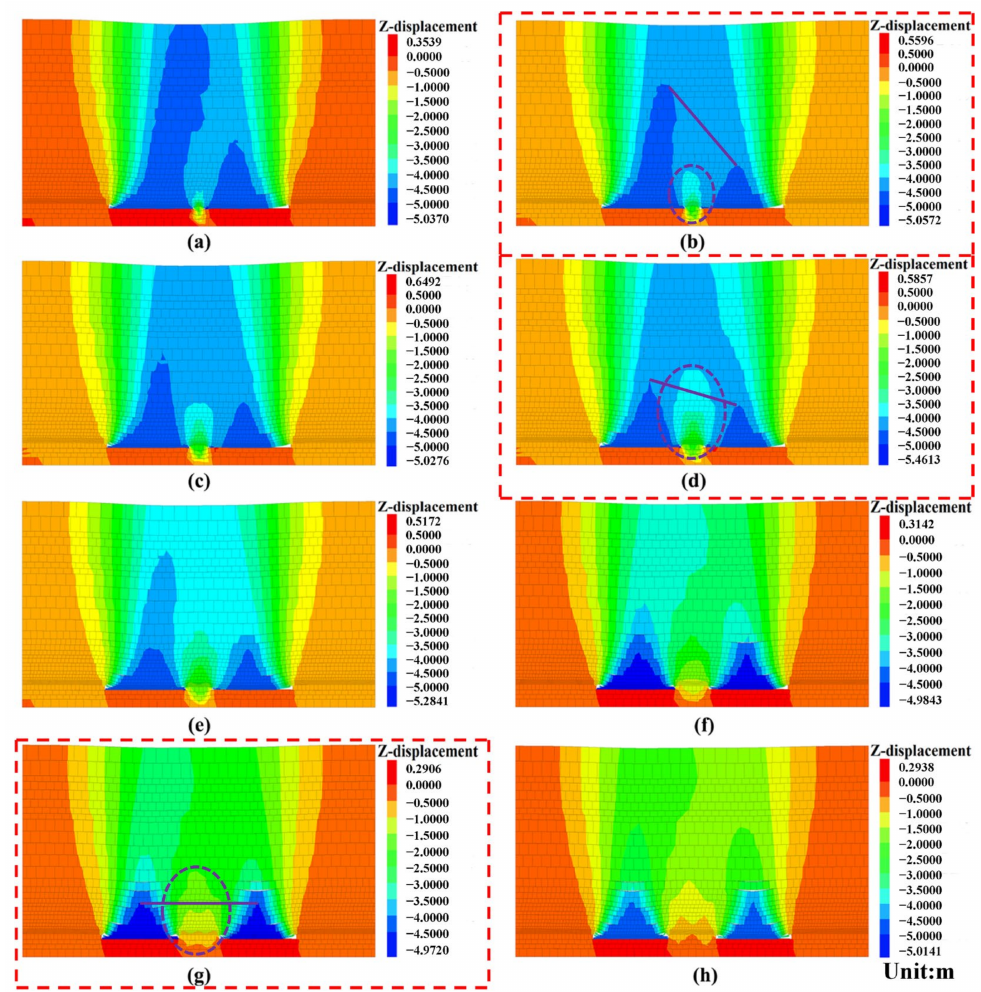
Figure 7. Subsidence conditions of overlying strata in the GAWF for different section coal pillar widths. ( a ) 10 m. ( b ) 15 m. ( c ) 20 m. ( d ) 25 m. ( e ) 30 m. ( f ) 40 m. ( g ) 50 m. ( h ) 60